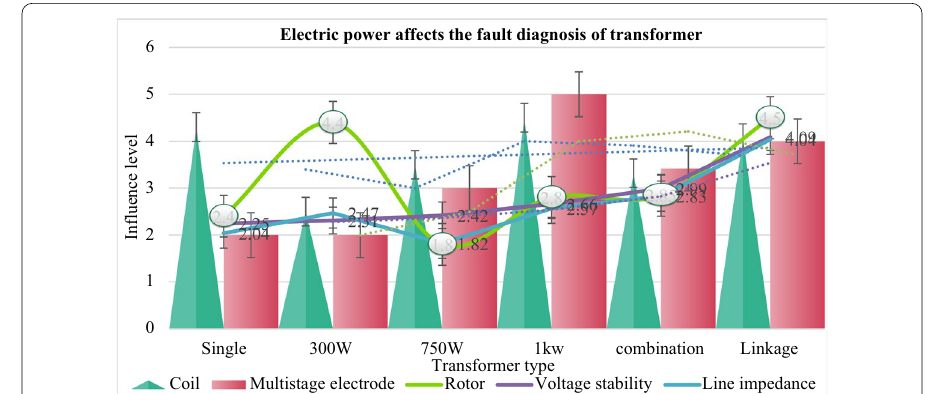
Fig. 11 Electric power affects the fault diagnosis of transformer